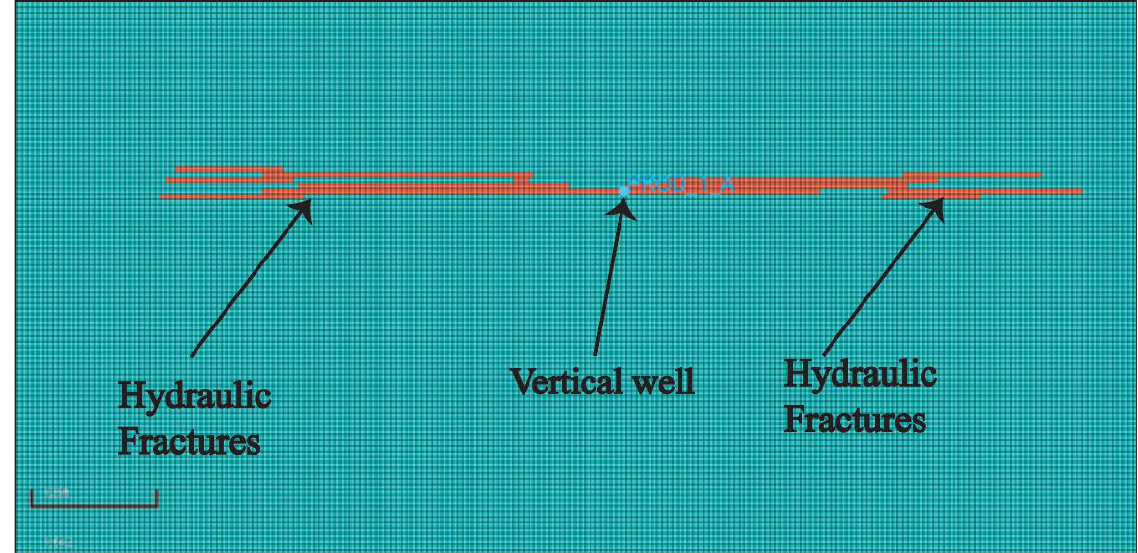
Figure 1. Synthetic hydraulic fractured well and reservoir.